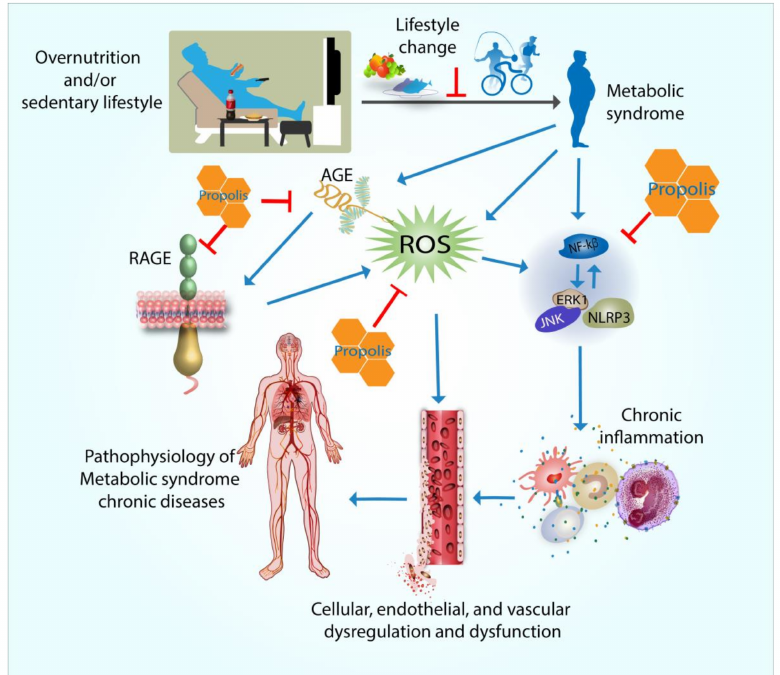
Figure 1. The mechanisms of action of propolis in ameliorating metabolic syndrome (MetS). MetS is induced by overnutrition and/or sedentary lifestyle. The first step of preventing MetS from developing is lifestyle modification. Once developed, MetS induces the formation of advanced glycation end products (AGEs), oxidative stress in the form of increased level of reactive of oxygen species (ROS), and chronic inflammation. AGEs bind to their receptors (RAGEs) and consequently induce further ROS production. ROS promote cellular dysfunction and dysregulation by either directly affecting the cells or inducing chronic inflammation. Chronic inflammation manifests in increased levels of pro-inflammatory cytokines through the upregulation of NF- κ B, ERK, JNK, and NLRP3 inflammasome signaling pathways. Chronic and prolonged cellular, endothelial, and vascular dysfunction and dysregulation from increased AGEs, ROS, and inflammation result in the pathophysiology of MetS and its diseases. Propolis with its antioxidant and anti-inflammatory properties acts by directly inhibiting AGEs and RAGEs, ROS production, and the inflammation signaling